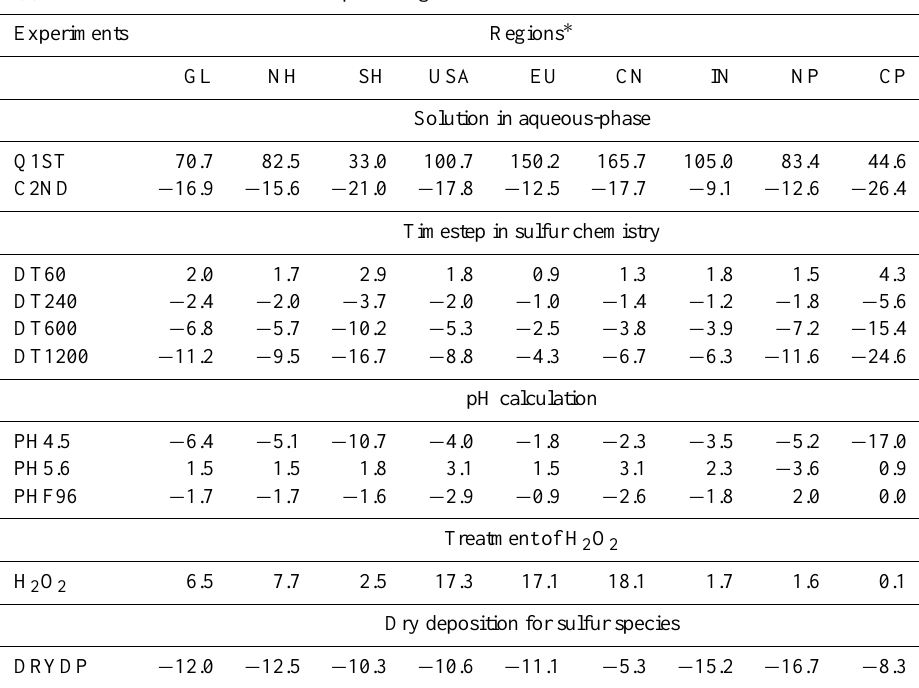
Table 4. Annual mean relative bias (RB), defined as RB=( S − C )/ C where S and C represent results simulated by the simplified and improved methods: (a) sulfate surface concentrations and (b) sulfate column burdens. The simplified methods are different in each experiment whose abbreviations are described in Table 3. The improved method corresponds to the experiment named as CTL in Table